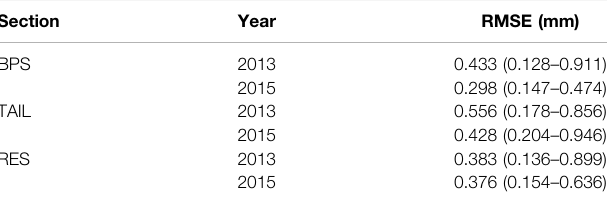
TABLE 2 | Average root mean square errors (RMSE; mm) of individual growth curves and their associated credible interval CI